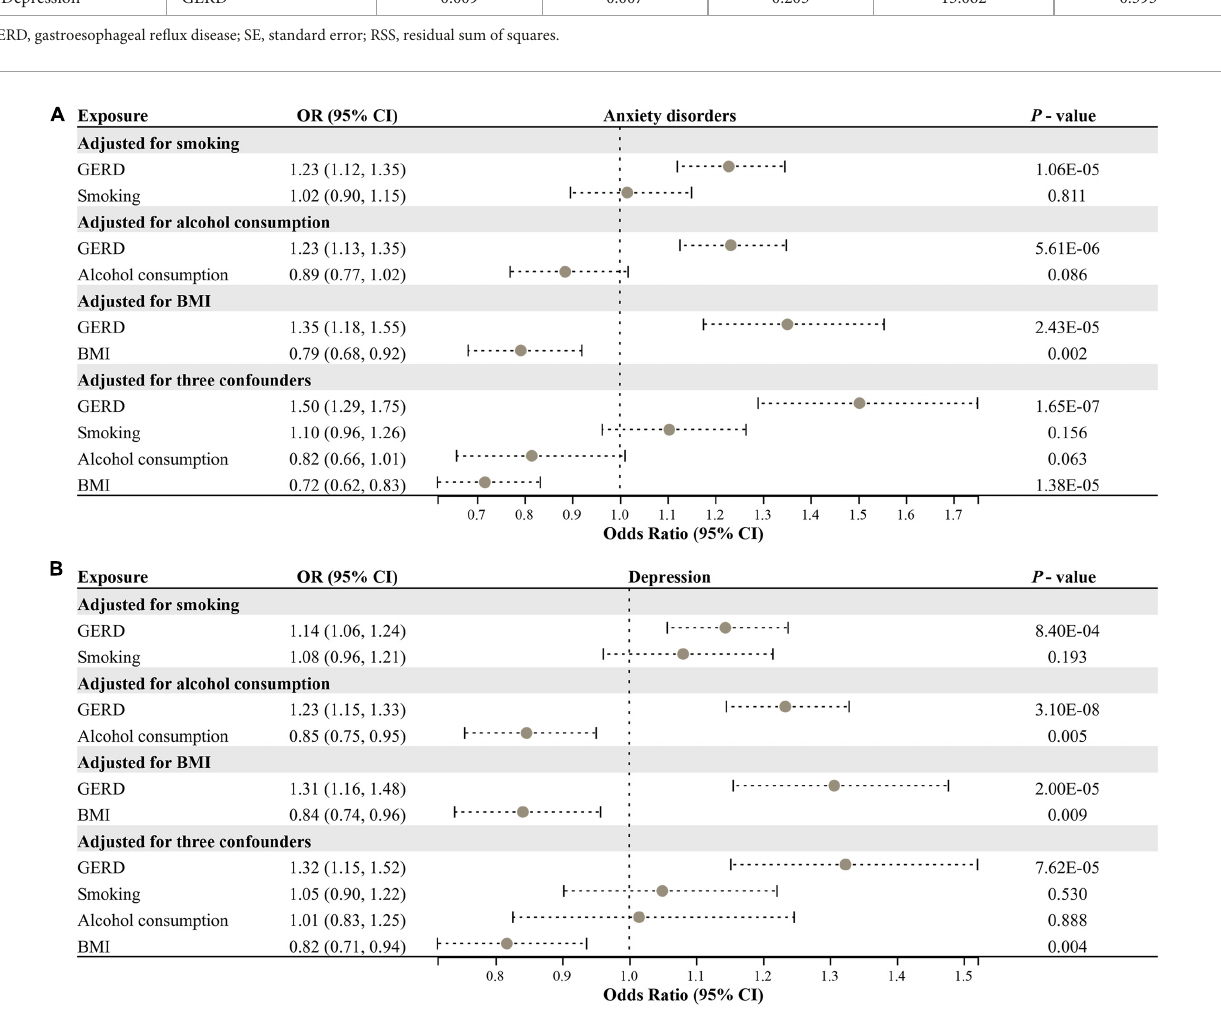
FIGURE4 Multivariable MR analysis for assessing the causal effect of GERD on anxiety disorders and depression. (A) Forest plot of the causal effect of GERD on anxiety disorders after adjusting for confounders. (B) Forest plot of the causal effect of GERD on depression after adjusting for confounders. OR, odds ratio; CI, confidence interval; GERD, gastroesophageal reflux disease; BMI, body mass